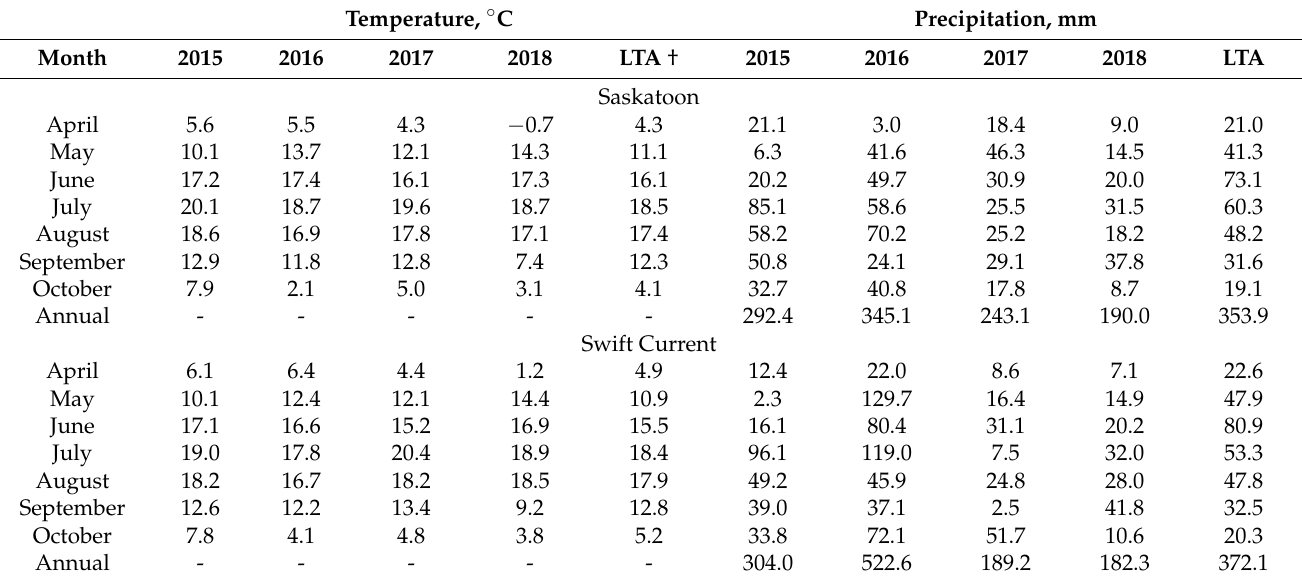
Table 1. Monthly (April–October), annual, and long-term precipitation and temperature over 4 yrs. in Saskatoon and Swift Current, Saskatchewan,